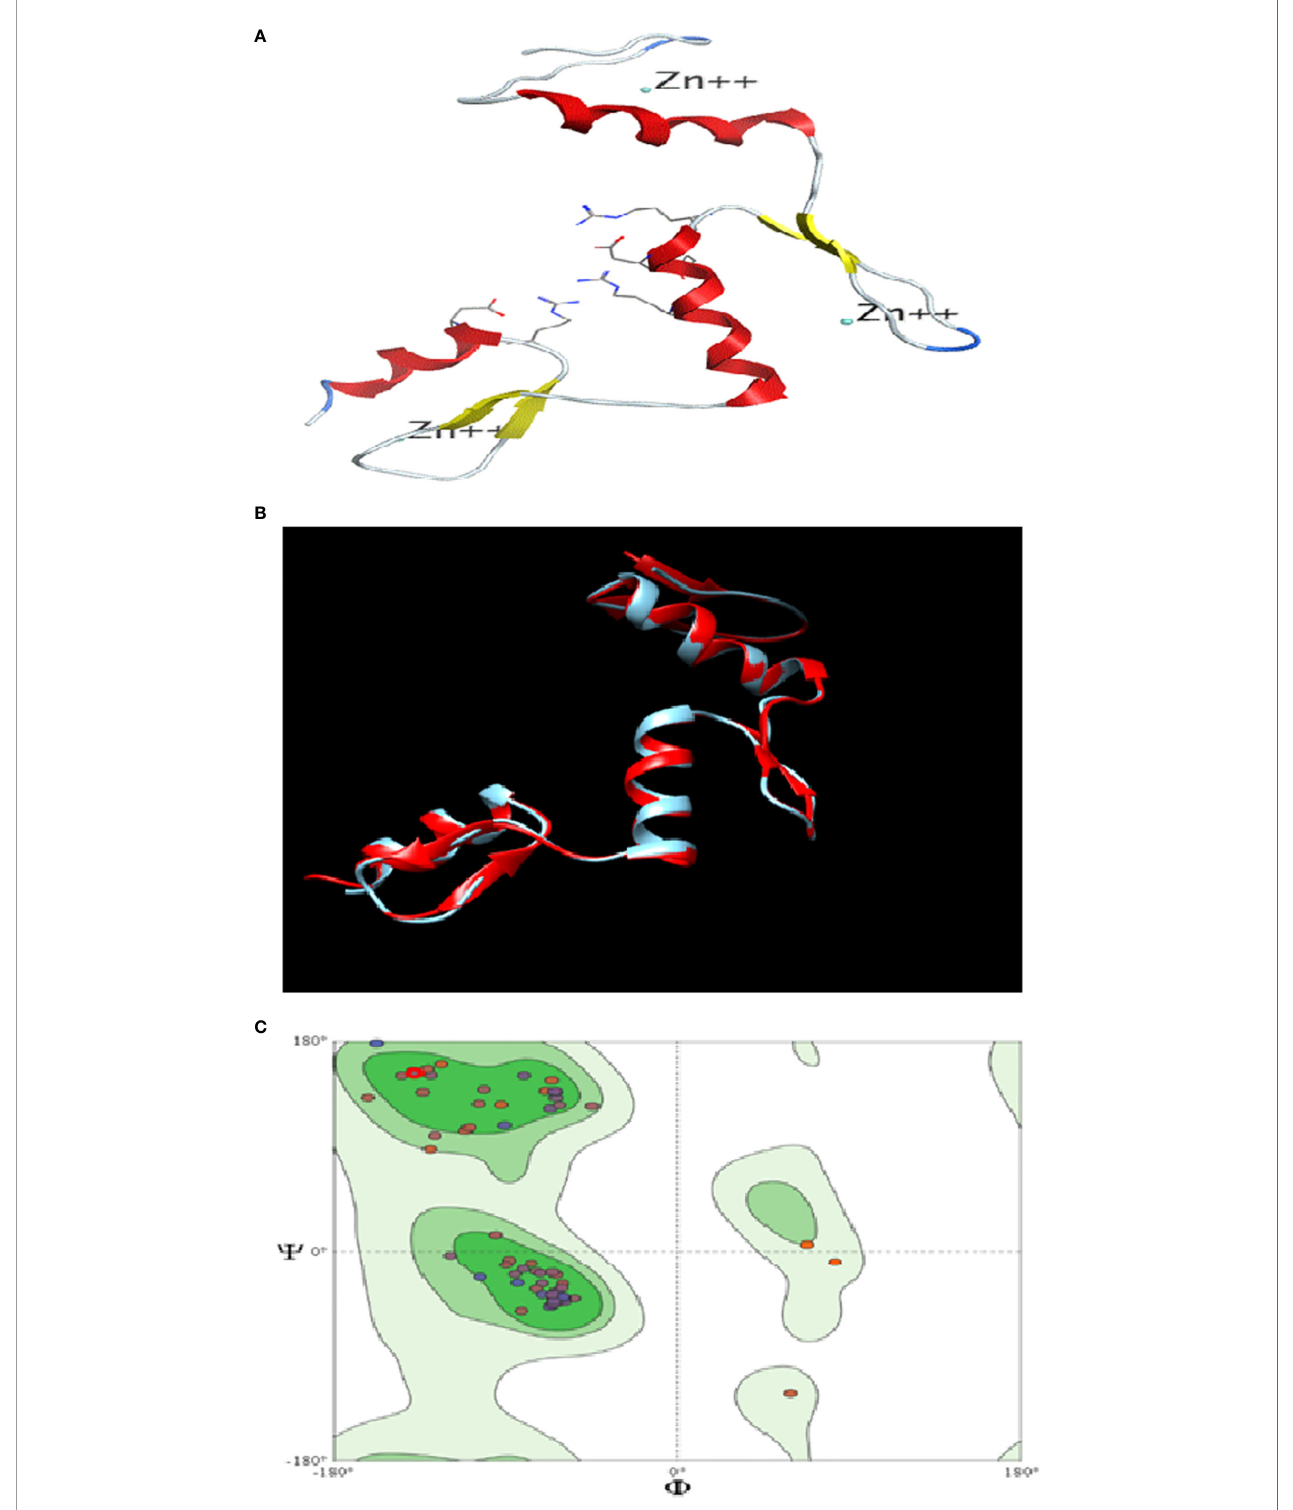
FIGURE 5 | In silico analysis of KLF9 . (A) Three-dimensional structure of KLF9 . (B) Comparison of the crystallographically determined structure 2bwu (labeled red ) and the predicted structure KLF9 (labeled blue ) for the analysis of structure conservation. (C) Ramachandran plot analysis determining the quality of the model. Most amino acids (95%) were found in favored regions, showing that the model is of good steriochemical